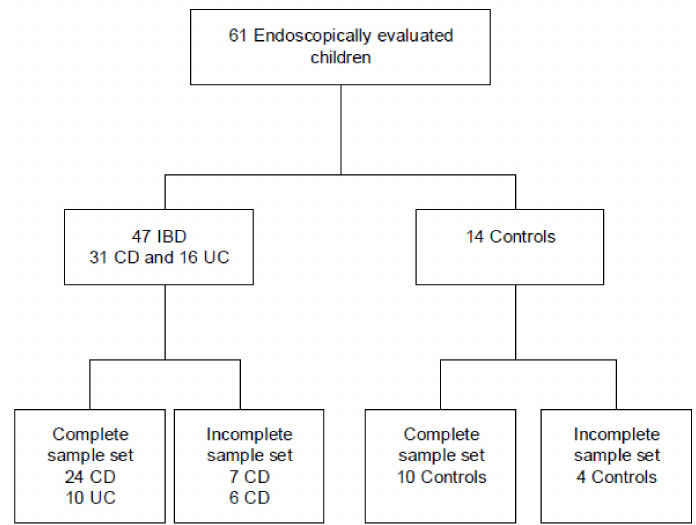
Figure 1. Inclusion flowchart Abbreviations: n, number; IBD, inflammatory bowel disease; CD, Crohn’s disease; UC, ulcerative